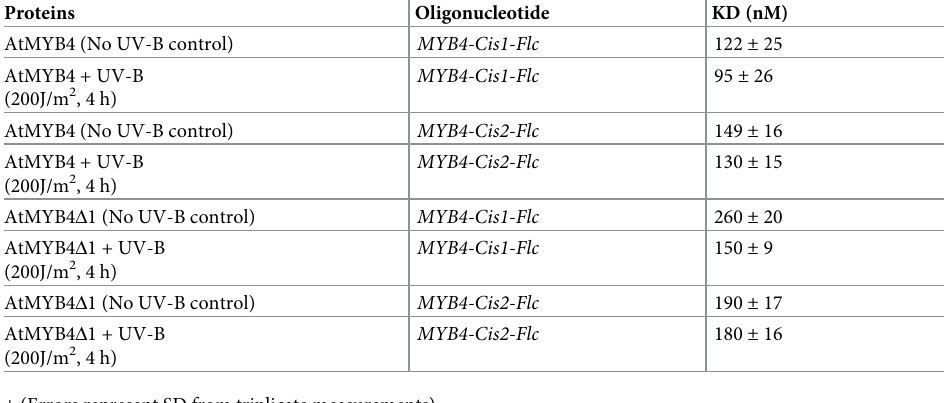
Table 5. Fluorescence anisotropy titration of purified recombinant AtMYB4 and AtMYB4 Δ 1 proteins using 5 μ M 3’ fluorescein tagged oligos ( MYB4-Cis1flc :5’AACCTTCAACCAAACCCAAAT3’ and MYB4-Cis2flc : 5’GACCTATAATATCTGGCGAT3’ ,